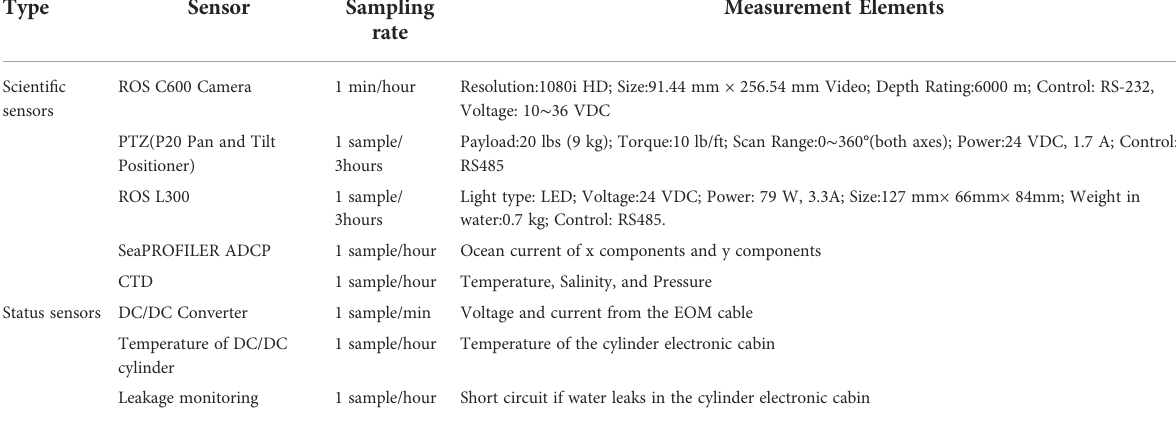
TABLE 2 Scienti fi c and status sensors for the benthic observation